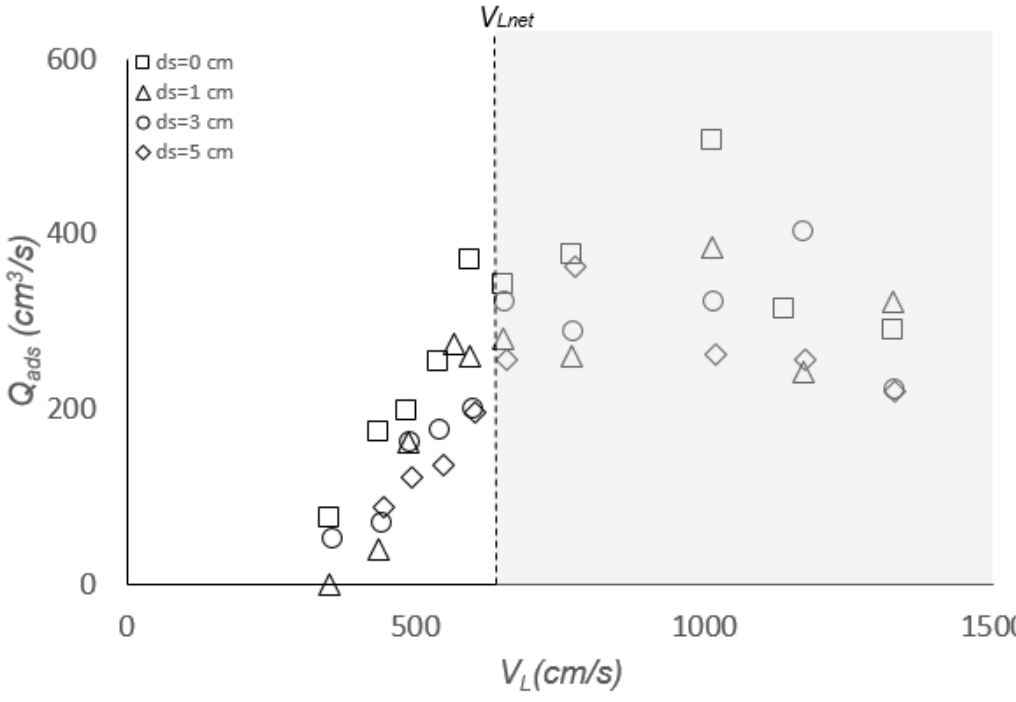
Figure 8. Disentrainment flow rates as d s increases from 0 to 5 cm for l ADR = 40 cm.